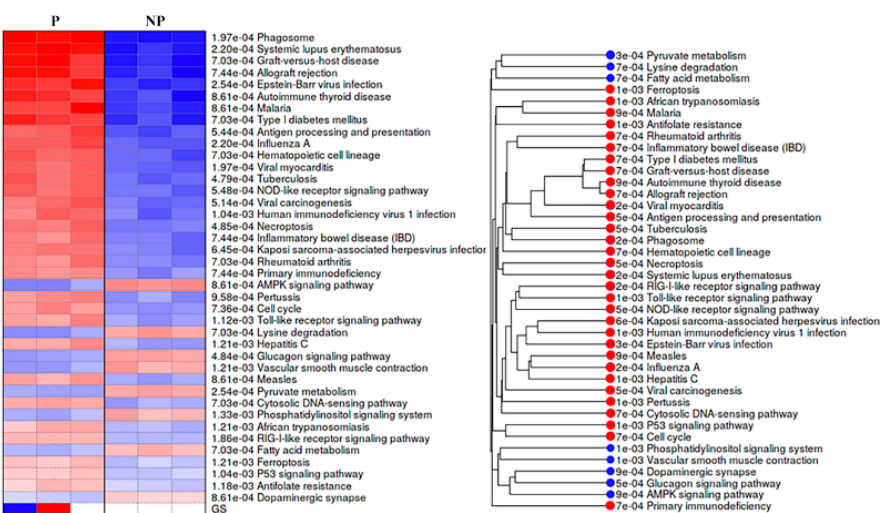
Figure 5. Pre- ranked gene set enrichment analysis (PGSEA) using KEGG pathways for the differentially expressed genes. Pathways activated are shown in red, and suppressed pathways shown in blue alongside the corresponding pathway tree are presented. The red and blue color gradients represent the level of activation/ suppression, the higher level of activation is shown in dark red and a higher level of suppression is shown in dark blue. NP-non-pregnant; P-pregnant.